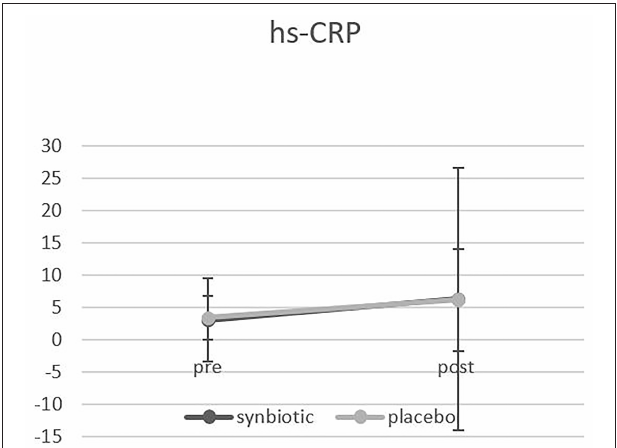
FIGURE 3 | Shows the Comparison of hs-CRP changes between the two groups before and after the